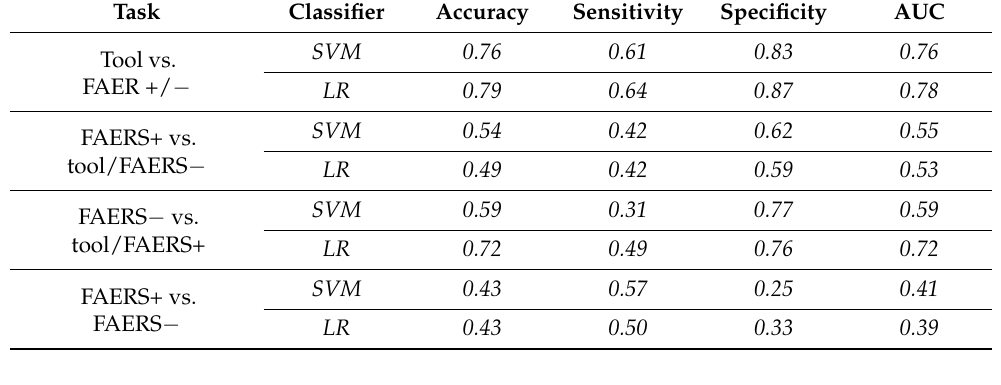
Table 4. One-vs.-rest classification performance per compound group. Task denotes the compound groups attempted to separate and classifier denotes the ML model utilized in the classification. While tool compounds can be separated moderately well from the FAERS-positive (+) and FAERS-negative ( − ) compounds, the poor classification performance for the remaining groups implies the lack of a clear pattern distinguishing the FAERS − and FAERS+ compounds.